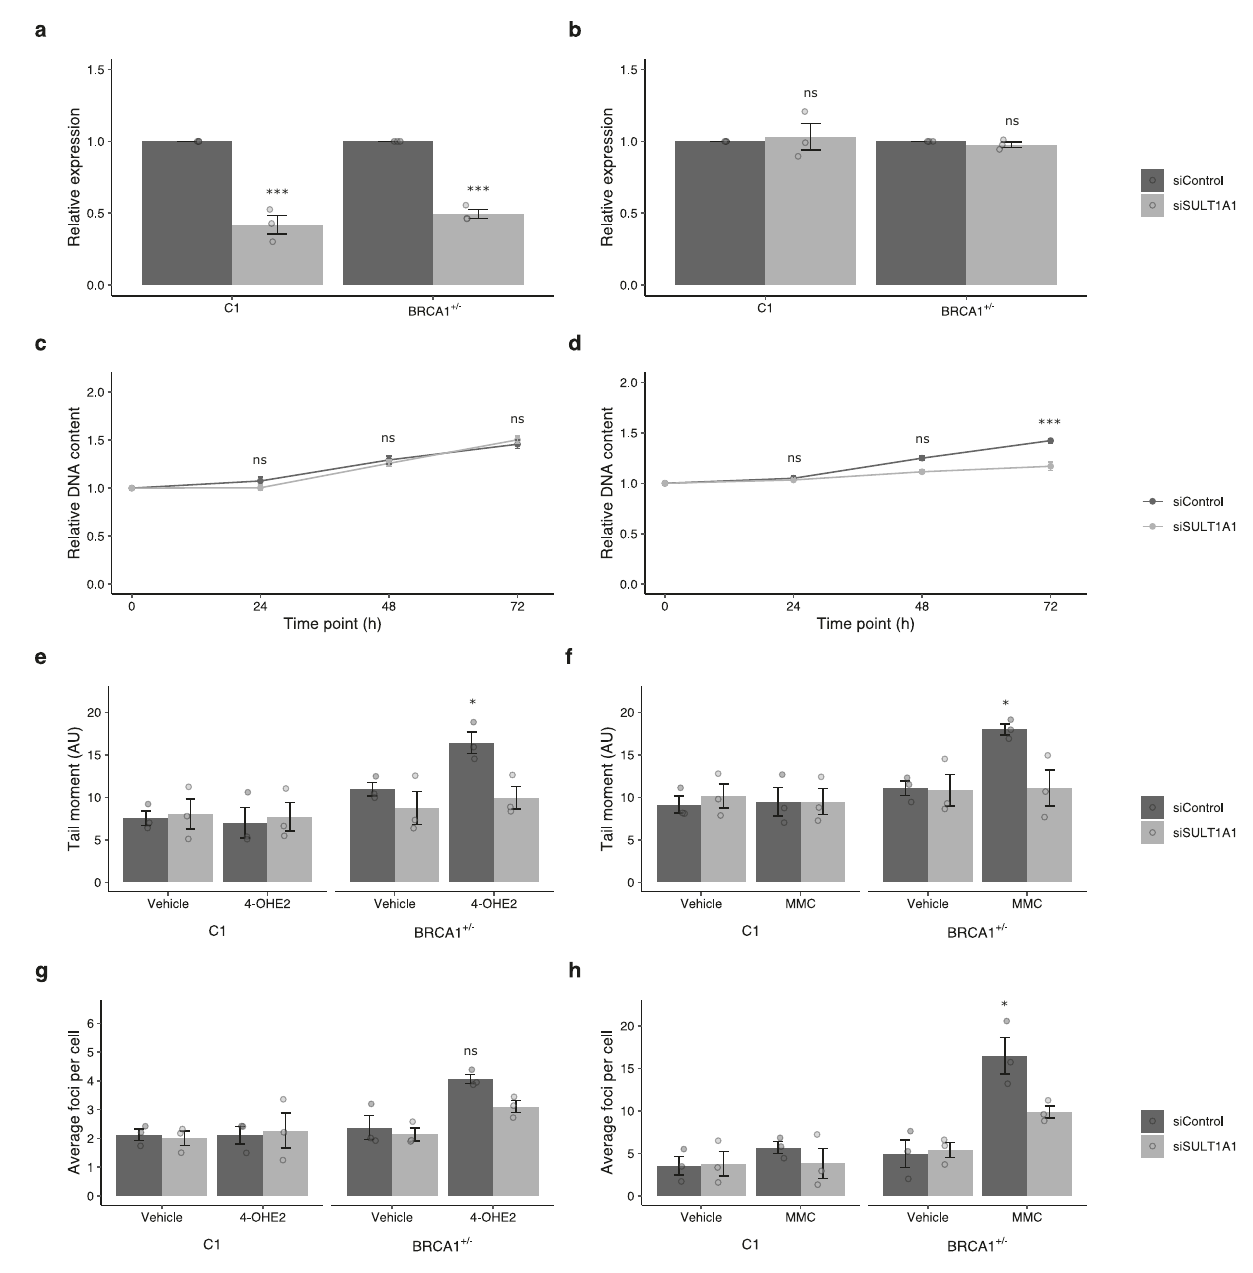
Fig. 3 siRNA knockdown of SULT1A1 reduces proliferation and DNA damage of MCF7 – BRCA1 + / − cells but not MCF7 – C1 cells. Expression of ( a ) SULT1A1 and ( b ) BRCA1 72 h post transfection. Relative DNA content of transfected ( c ) MCF7 – C1 and ( d ) MCF7 – BRCA1 + / − cells 72 h post transfection. Quanti fi cation of transfected DNA damage using the comet assay ( e , f ) and ϒ -H2AX/53BP1 foci quanti fi cation ( g , h ) for MCF7 – C1 and MCF7 – BRCA1 + / − cells, with and without siSULT1A1 transfection, 21 h post treatment with 1 μ m 4-OHE2 ( e and g ) or 10 μ m MMC ( f and h ). Signi fi cance of differences in relative expression and DNA content was determined by unpaired two-sided t -test. Gene expression and DNA content of siSULT1A1 transfected cells normalised to siControl transfected cells. Differences in DNA damage were determined by two-way analysis of variance. Example images of comet and ϒ - H2AX/53BP1 foci shown in Supplementary Figs. 3 – 6. 4-OHE2 = 4-hydroxyestradiol; MMC = Mitomycin C; Error bars = standard error of the mean; ns = p > 0.05; * p < 0.05; ** p < 0.01; *** p < 0.001; n = 3 independent biological